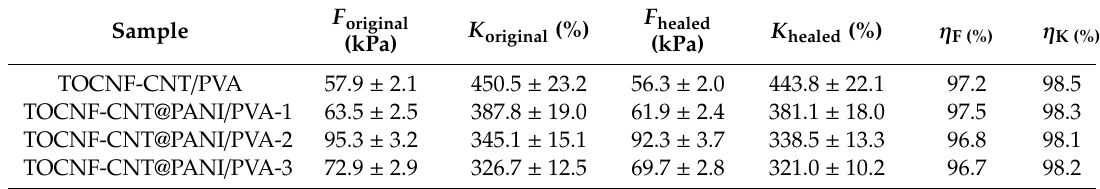
Table 3. Tensile strength and tensile rate of hydrogels before and after a 20 s self-healing. F original F healed K original (%) K healed (%) η F (%) η K (%) Sample (kPa) (kPa) TOCNF-CNT / PVA 57.9 ±